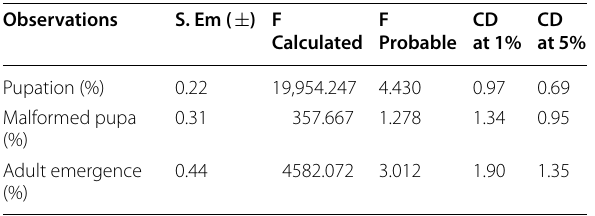
Table 2 Effect of endophytically colonized Beauveria bassiana UHSB-END1 in tomato plant on growth and development of Spodoptera litura under in vivo condition Observations